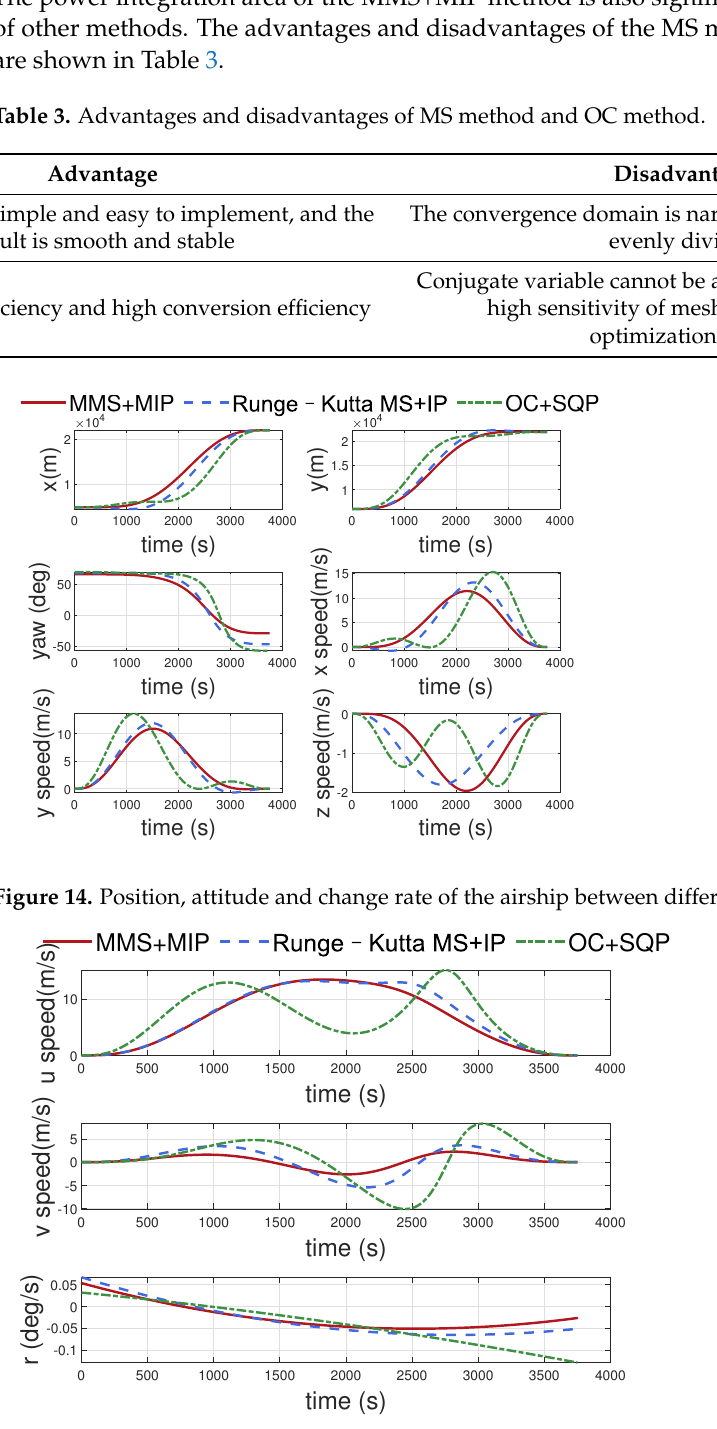
Figure 15. Horizontal speed and yaw angle velocity of the airship between different